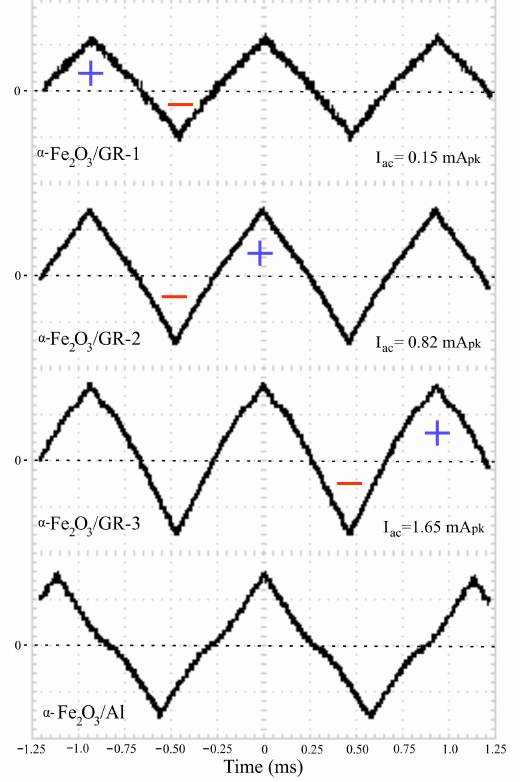
Figure 7. Current signals measured from the architecture of Figure 6, where three different inter- faces are evaluated. The α -Fe 2 O 3 /Al interface was included as reference to validate how energy distribution might be responsible of weight